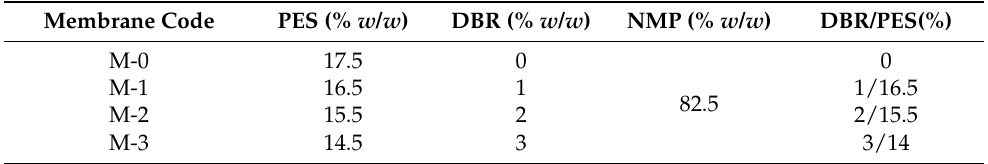
Table 1. Composition of the prepared PES